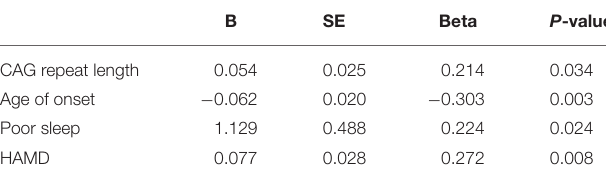
TABLE 4 | Multivariate linear regression analysis of FSS